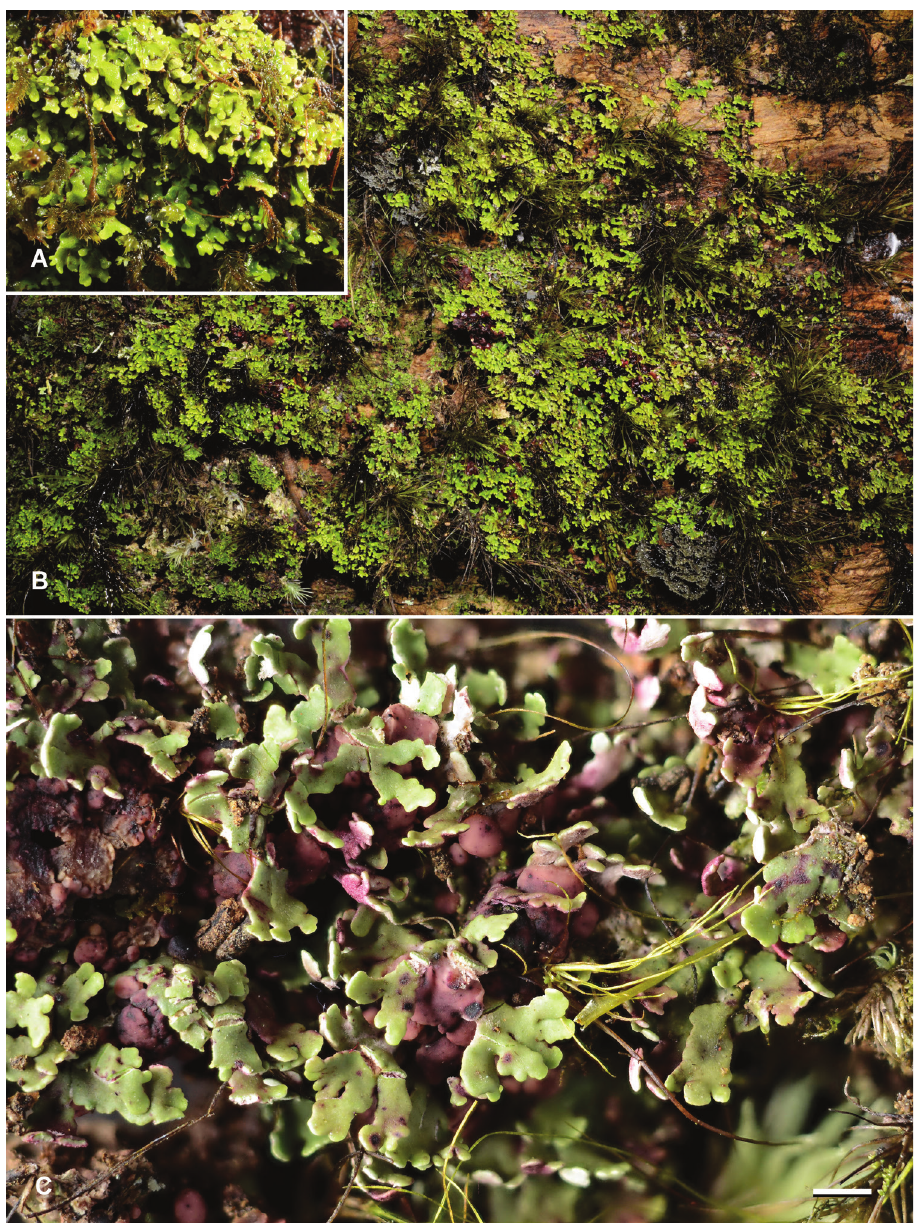
Figure 4. Krogia macrophylla A field photograph of JR36047 B field photograph of holotype C her- barium photograph of holotype. Scale bar: 1 mm. Photo: J. Rikkinen ( A, B ), E. Timdal ( C ). Type. New Caledonia, Province Sud, Mont Mou Nature Reserve, in low dense mist forest along foot path to the mountain summit, on tree trunk, 22°03'39.66"S, 166°20'53.54"E, 1162 m alt., 2016-09-26, J. Rikkinen 36077 (H, holotype